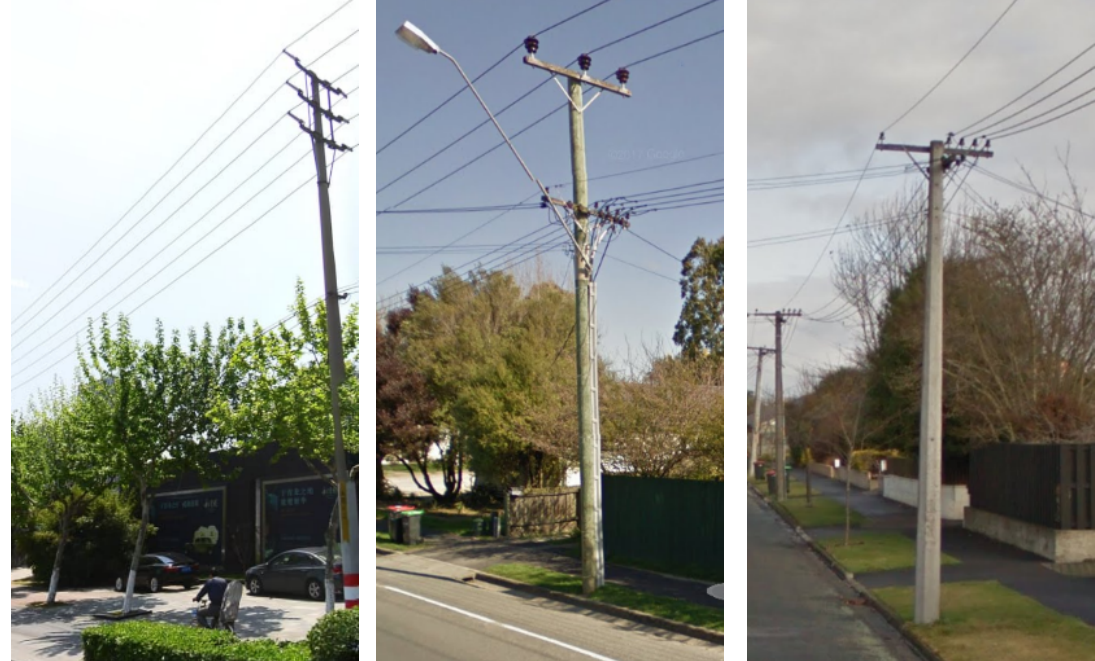
Figure 8. Comparison between Cheng’s Nanjing dataset ( left ), Gilberthorpes ( centre ), and Hounslow ( right ). Note the Nanjing image is from 2014 while the LiDAR survey was conducted in